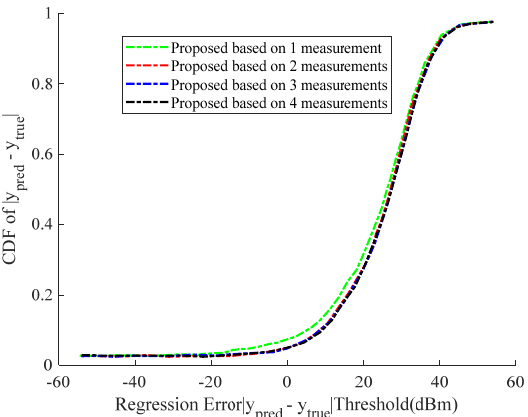
Figure 10. CDF of SNR with different numbers of inputs.